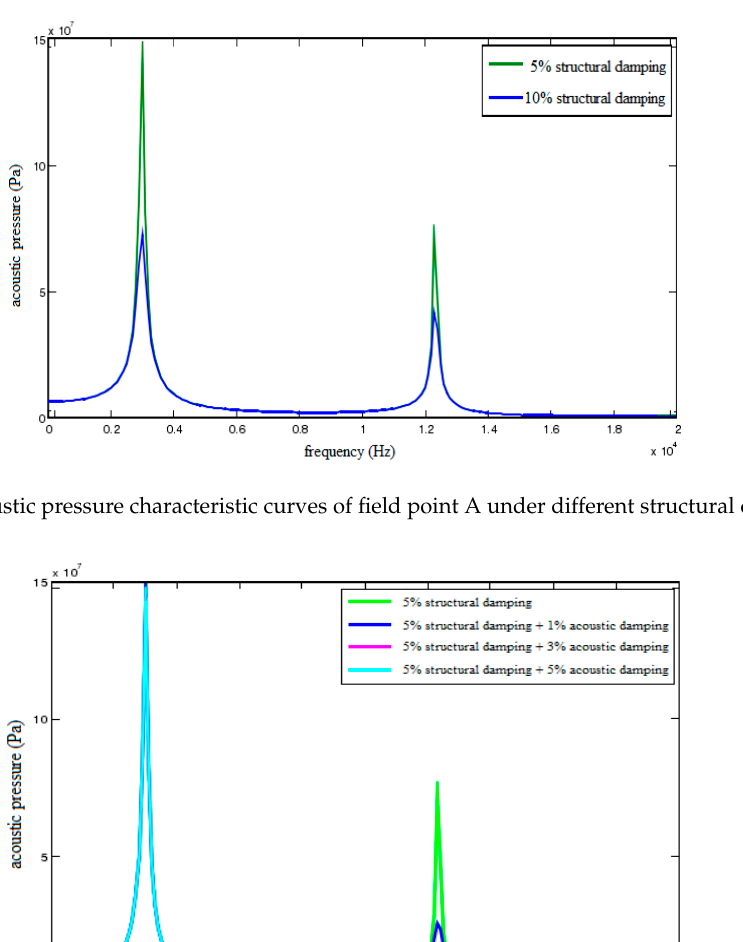
Figure 11. Acoustic pressure characteristic curves of field point A under different structural